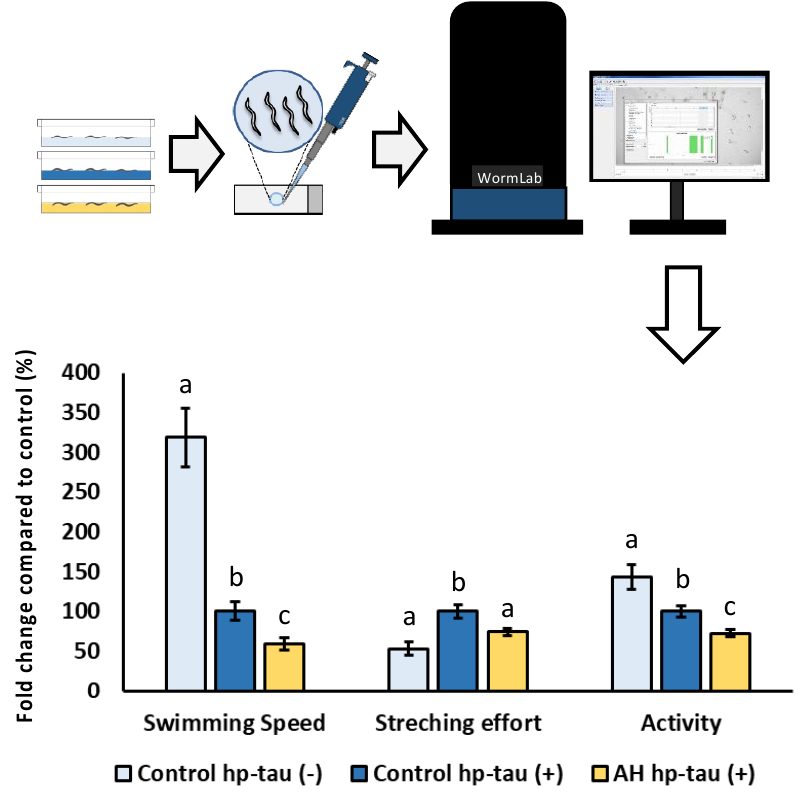
Figure 6. Schematic and analytical representation of the cytoprotective analysis of AH against behavioral changes related to tau protein-induced neurotoxicity in C. elegans . Results are mean ± SEM. For each parameter, different lowercase letters mean statistically significant differences ( p < 0.05).